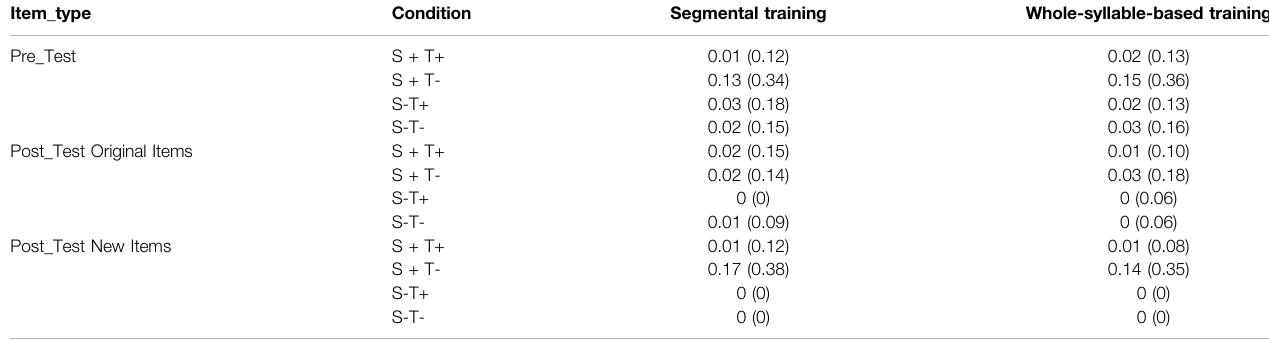
TABLE 2 | Error Rates (SDs in parentheses) on All Conditions and Item Types in the Same-Different Phonological Judgment Task in Both Segmental and Whole-Syllable- Based Training Groups. Item_type